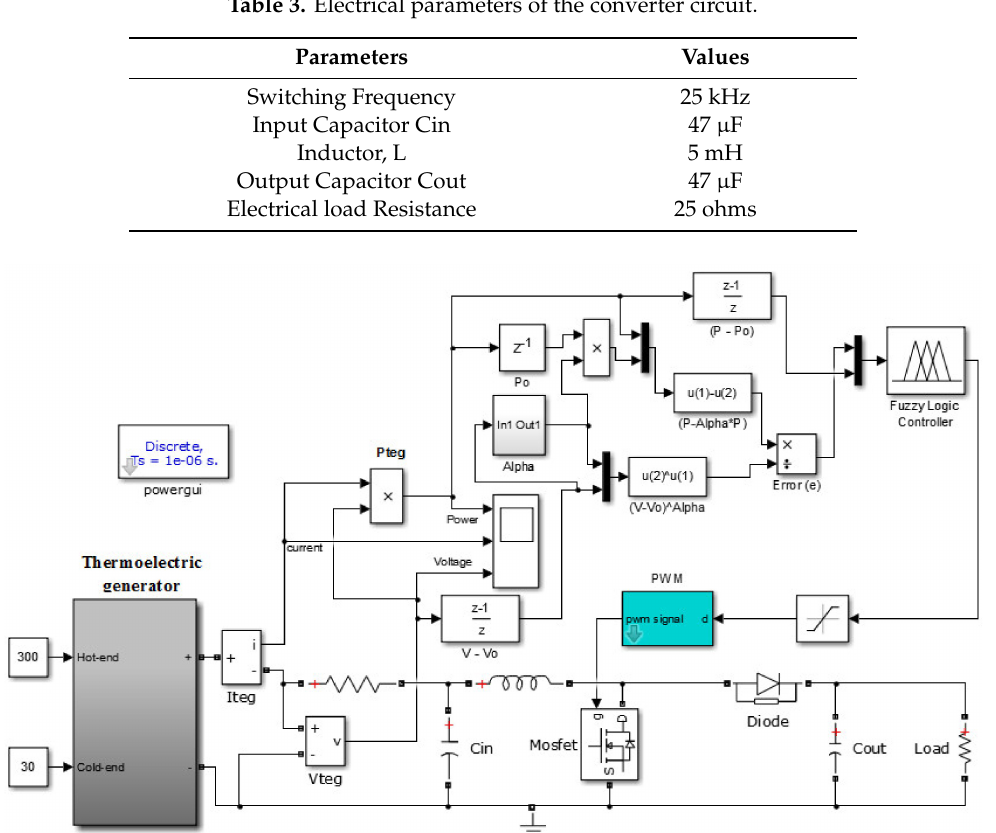
Figure 11. MATLAB-SIMULINK model of the VFOFLC-based MPPT